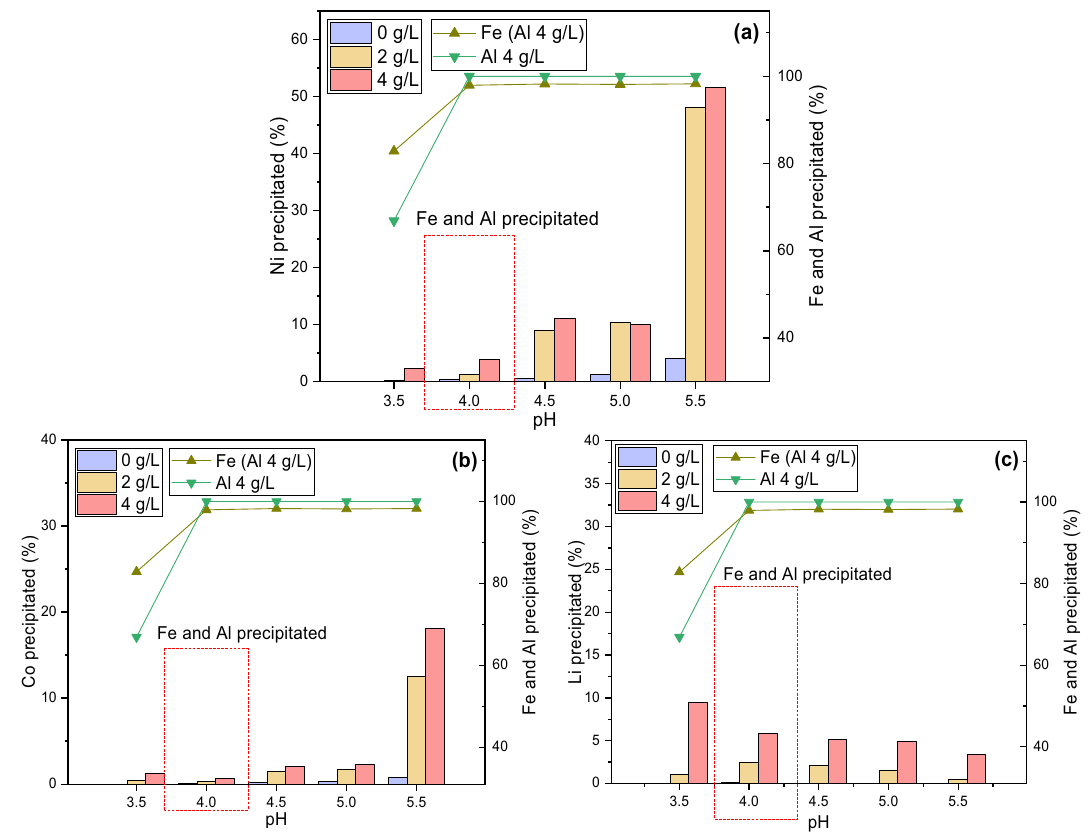
Figure 3. Precipitation of ( a ) Ni, ( b ) Co and ( c ) Li with LiOH as a function of Al concentration (0, 2, 4 g/L) in the